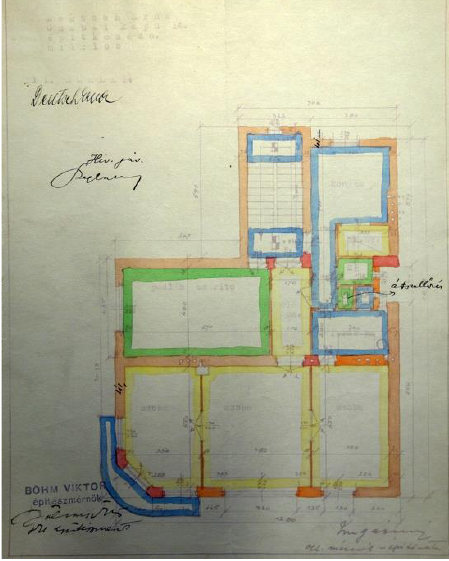
Figure 13. 16 Artúr Görgey street. Street façade. Architect: Victor Bohm, 1932 – 1934. Source: MNL BAZML IV. 1906/b. 1435/1934 .